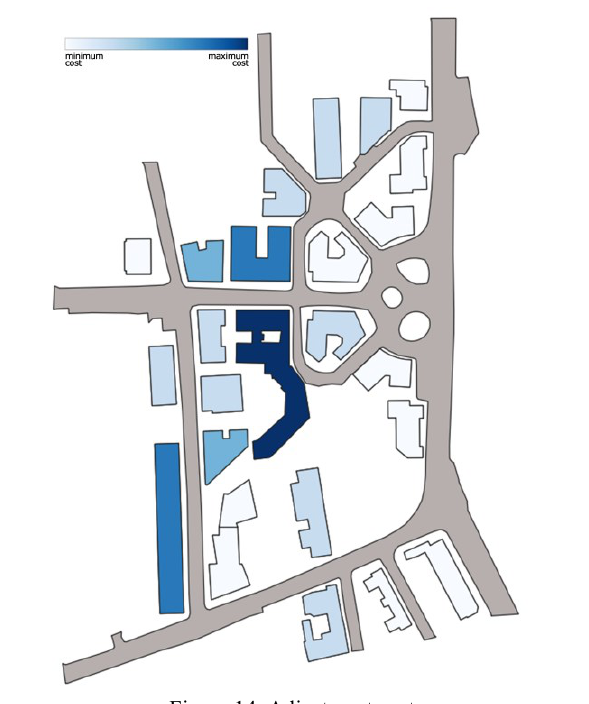
Figure 14. Adjustment costs.